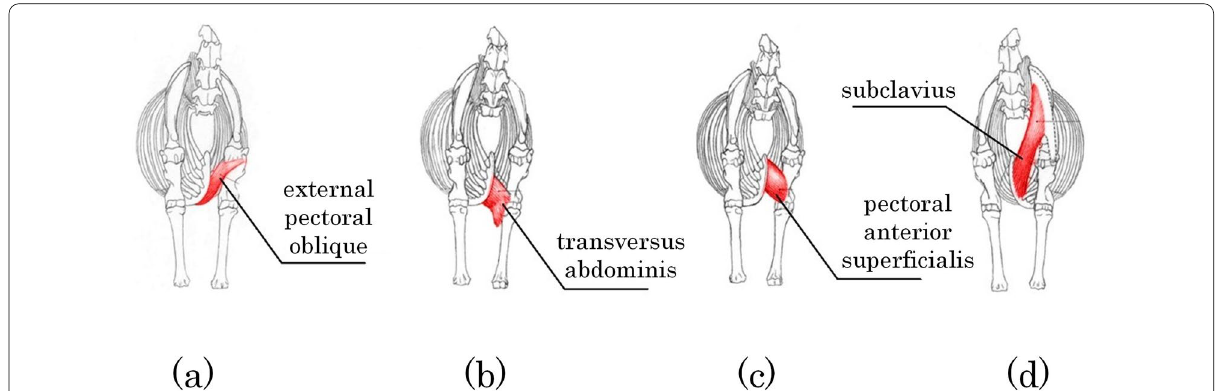
Figure 3 Major muscles of the ruminant ventral muscle groups: a external pectoral oblique, b transversus abdominis, c pectoral anterior superficialis, d